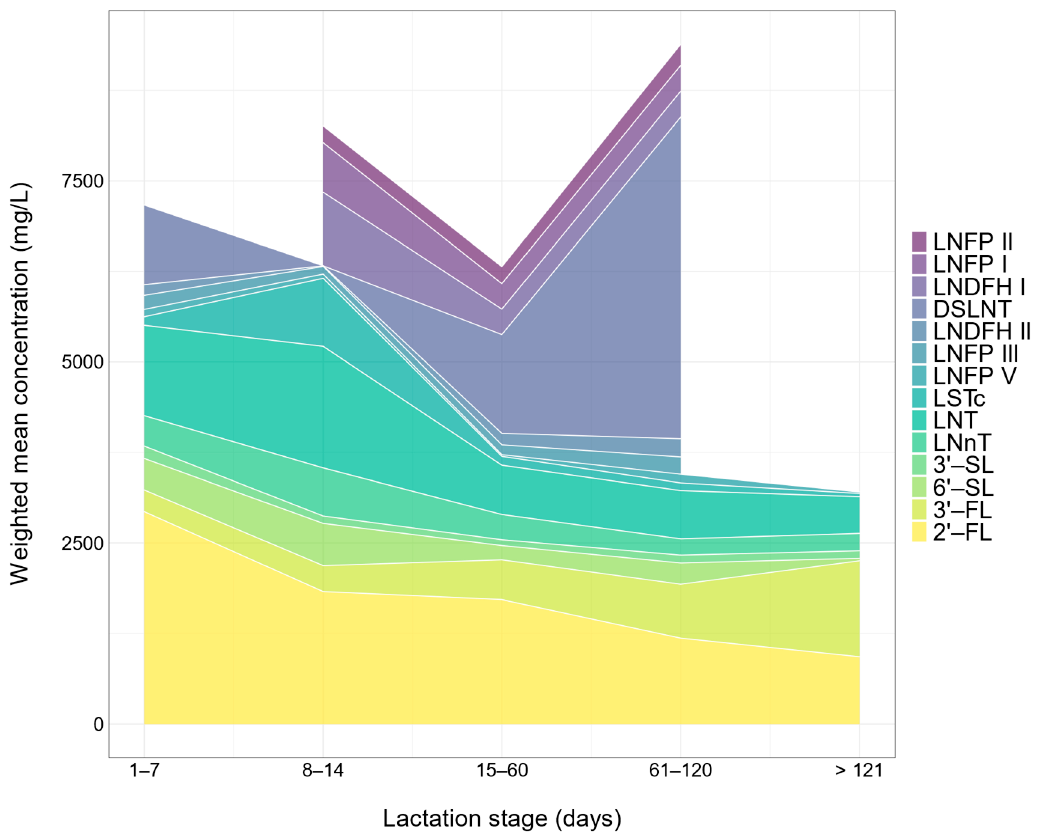
Figure 4. Longitudinal changes in HMO composition.